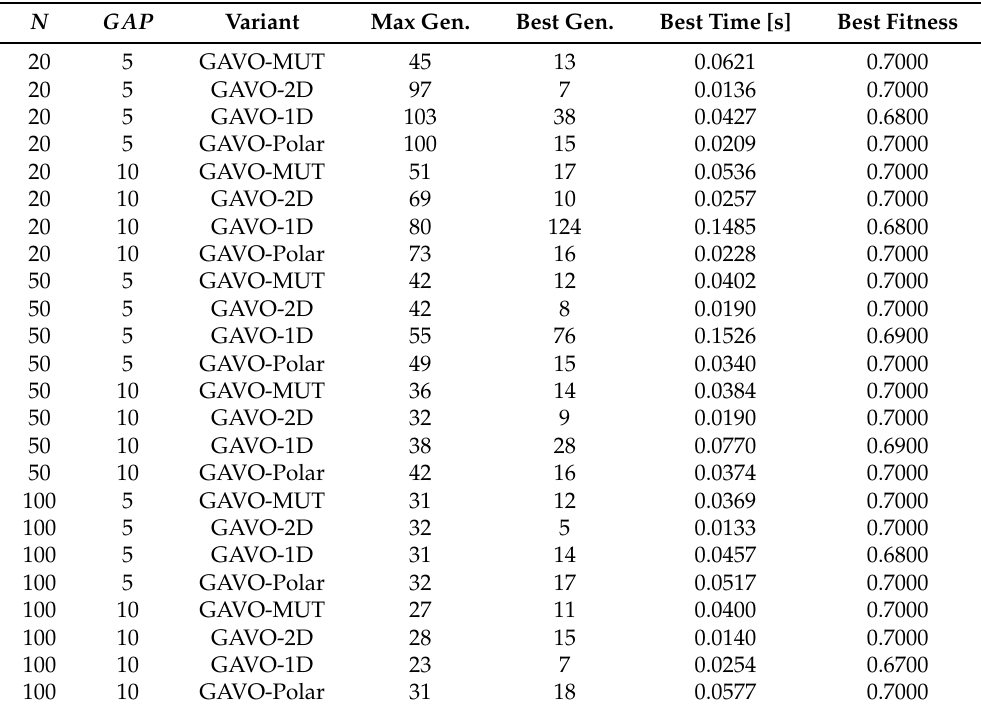
Table 1 represents the results using different parameters in the genetic algorithm. Strategy means the actual recombination strategy that was executed. ’Max Gen.’ means the number of the maximum generation that could be executed during the cycling time (0.1 s).